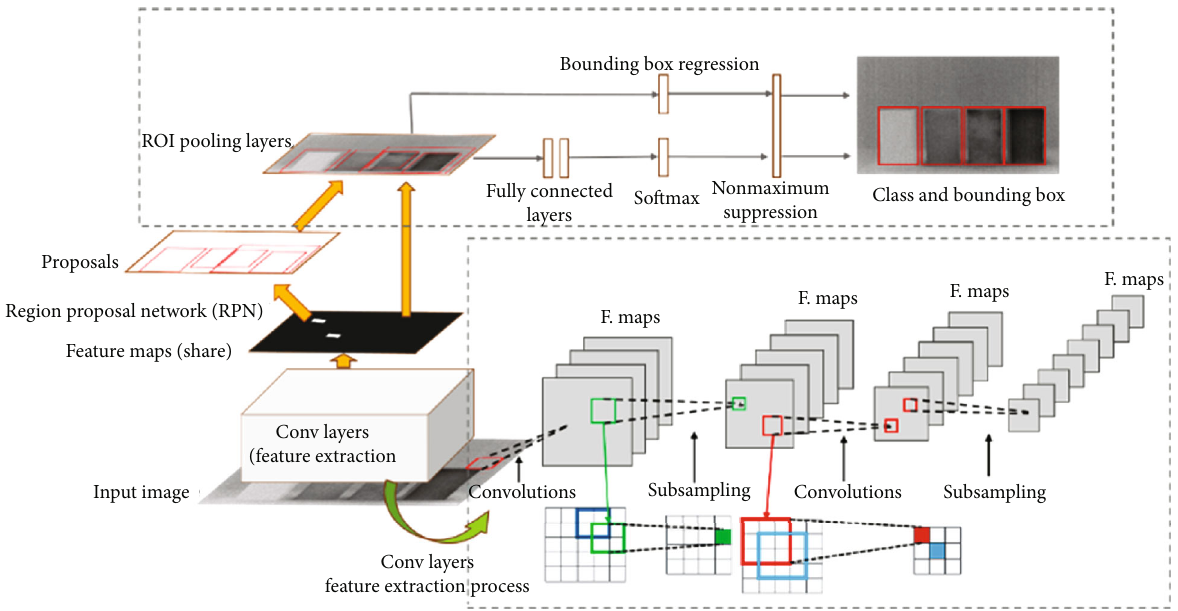
Figure 2: Schematic of the Faster R-CNN algorithm [35]. Table 1: Network structure parameters